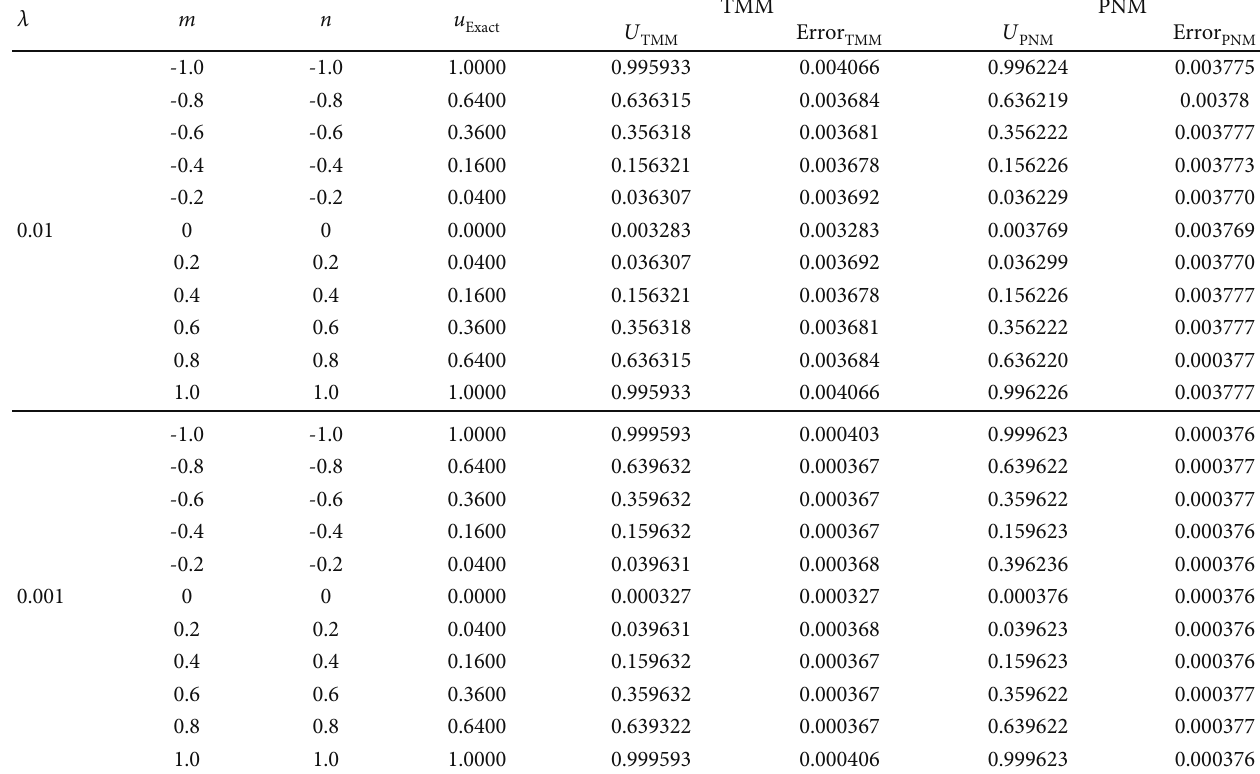
Table 4: Numerical values and absolute error values by using TMM and PNM, n = 20 , at nonlinear case k = 2 . λ m n u